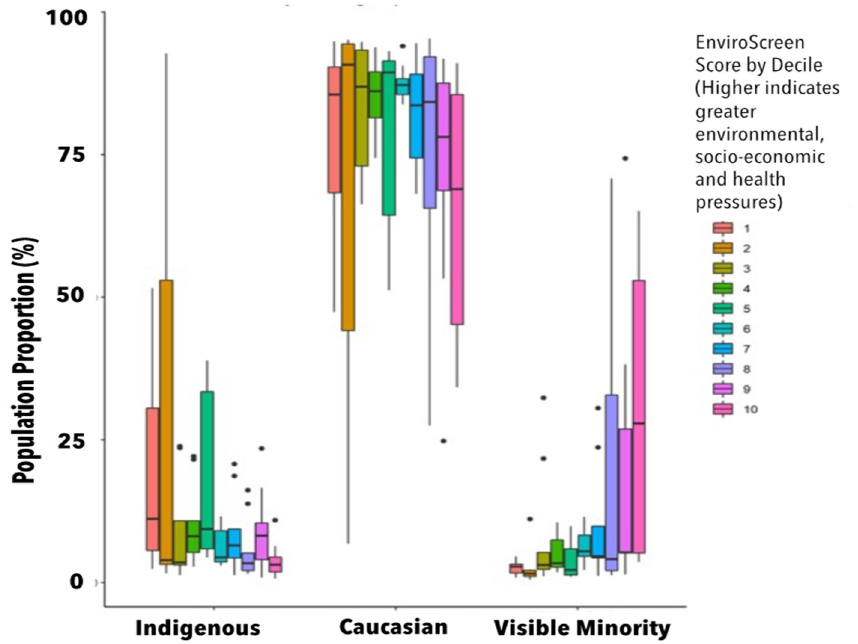
Figure 5. Within group racial/ethnic proportions by decile of BCEnviroScreen score, expressed as a proportion of all Local Health Areas in British Columbia, Canada.